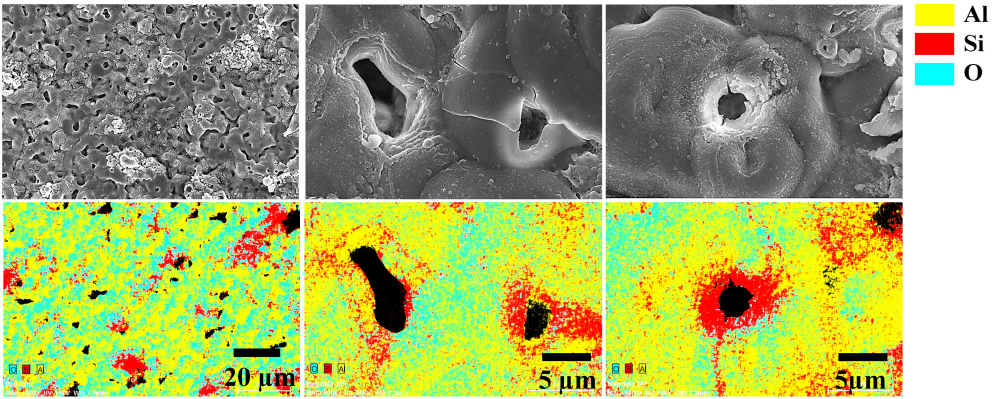
Figure 10. EDS mapping images showing distribution of Al, O and Si, where Si is preferentially located at the edges of the